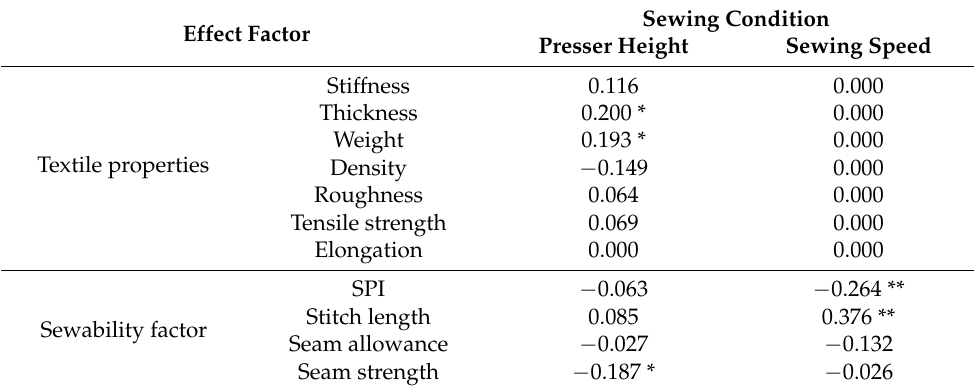
Table 8. Correlation coefficient between sewing conditions and textile properties or sewability in the lock stitch. Sewing Condition Effect Factor Presser Height Sewing Speed